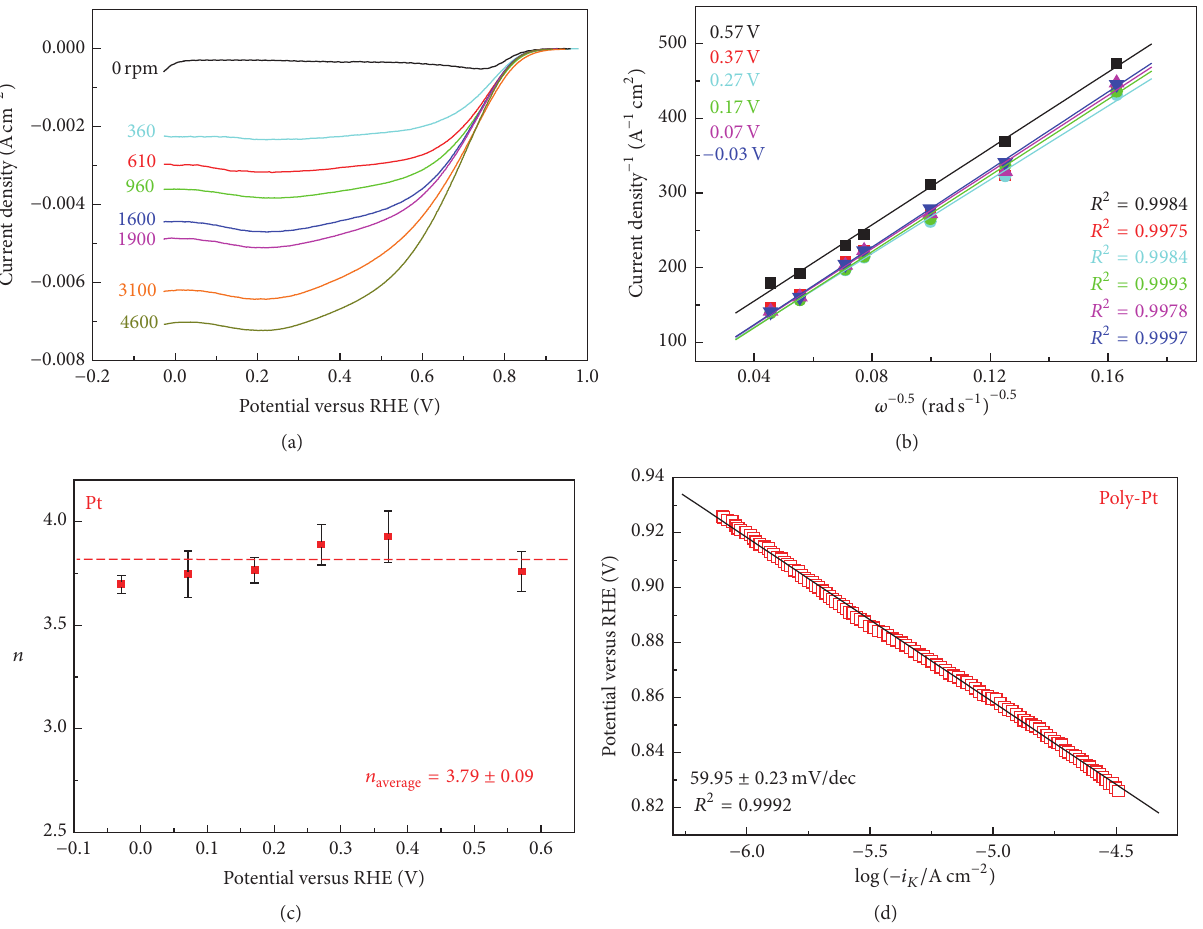
Figure 3: (a) RDE voltammograms (scan rate: 5mVs −1 ) of poly-Pt electrode in O 2 -saturated 0.1M KOH at different rotation speeds. The N 2 background has been subtracted. (b) Koutecky–Levich plots derived from the curves of Panel (a) at a series of representative potentials. Symbols are experimental data; lines are the linear regressions. (c) Dependence of the electron transfer number 𝑛 on the electrode potential. (d) Tafel plot obtained from RDE voltammograms at